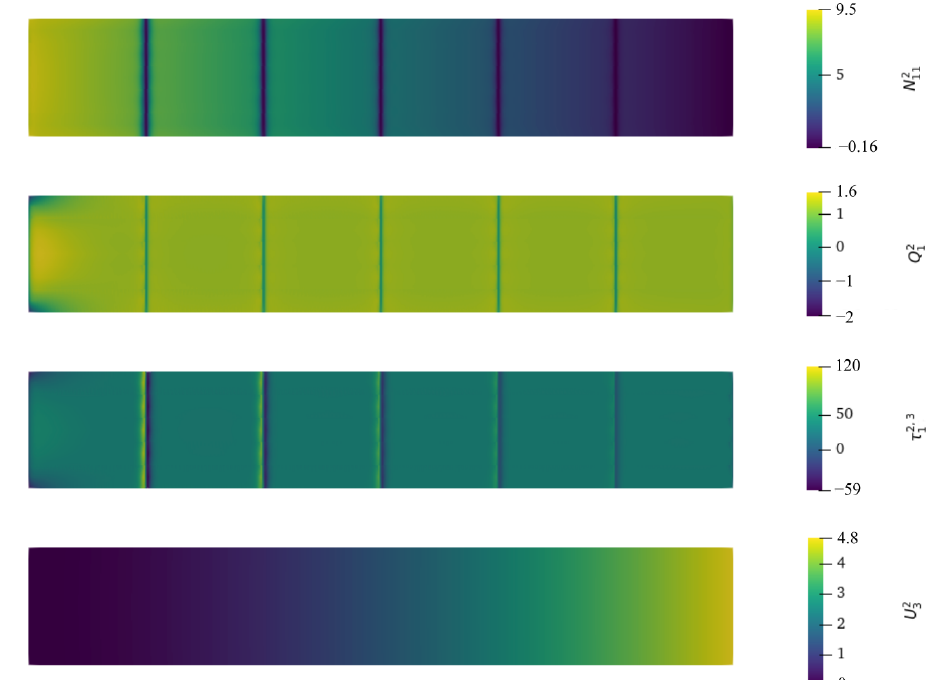
Figure 13. Generalized stresses and vertical displacement fields in layer 2 ( N 2 MPa, U 2 in 3